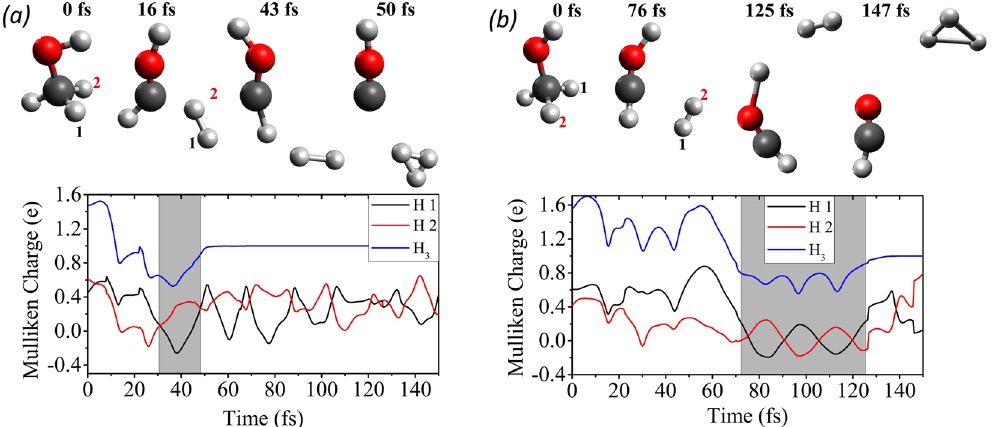
Figure 9. Snapshots from the two trajectories which result in the formation of H 3 + through two different pathways, ( a ) association of three hydrogen atoms initially attached to the same carbon atom and ( b ) association of two hydrogen atoms bound to a carbon atom with a hydrogen atom from a neighboring group. The associated Mulliken charges with each of the H 2 hydrogen atoms (numbered in the CH 3 OH structure as 1 & 2 and as H 1 & H 2 in the figure legends) as well as the total charge on the nascent trihydrogen cation are shown as a function of time. The grey area highlights the survival time of H 2 before the formation of H 3 +